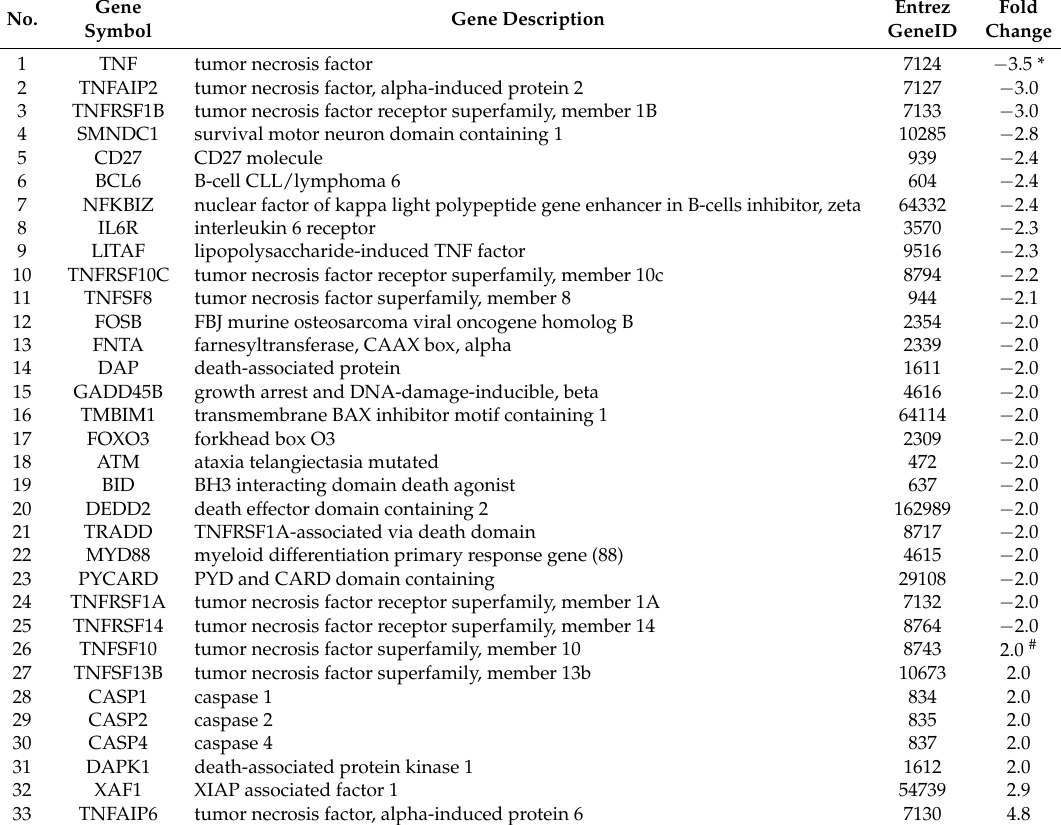
Table 2. The list of pro-apoptotic genes with the largest change of expression (at least 2 folds) in CD34+ cells from GHD patients treated for 6 months with GH-TS compared to GHD subjects before GH